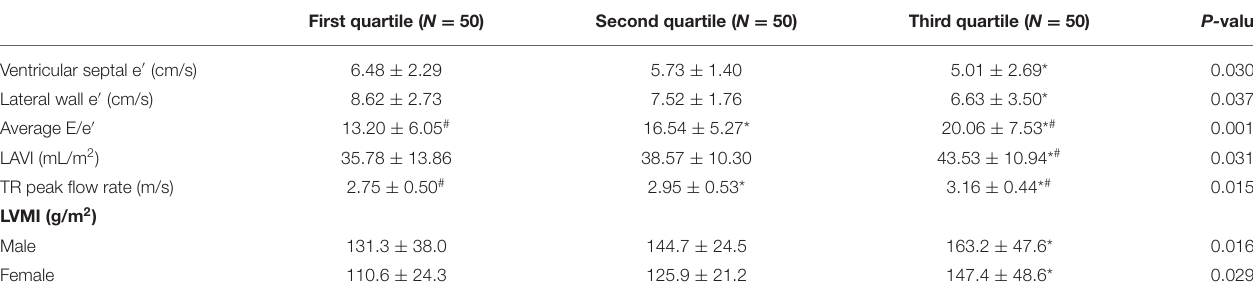
TABLE 1 | Comparison of left ventricular diastolic function and left ventricular remodeling indexes in HFpEF patients with different liver hardness groups. First quartile ( N = 50) Second quartile ( N = 50)